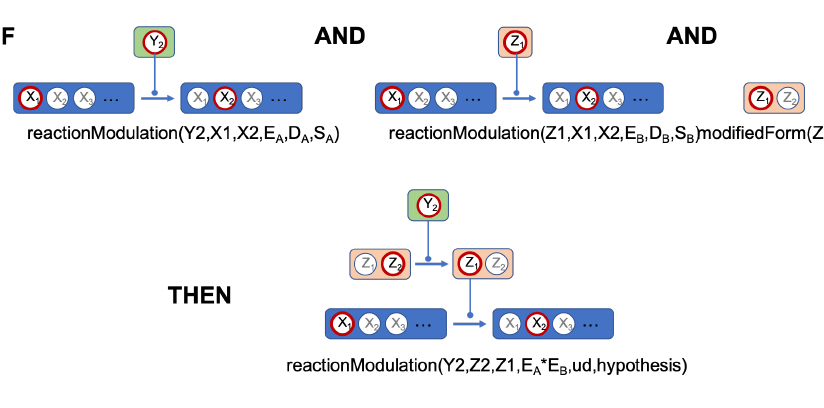
Figure 4. Schematic representation of a rule.